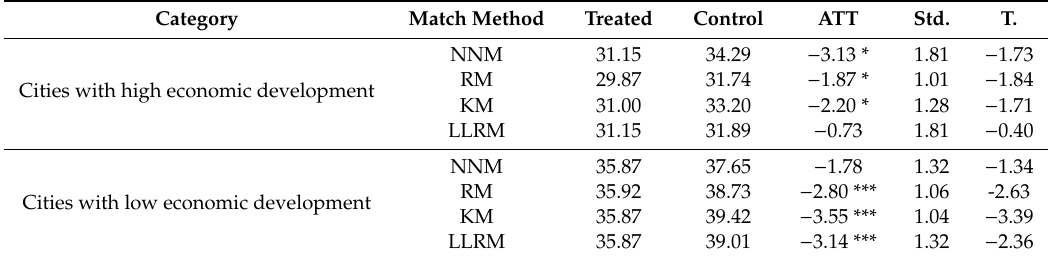
Table 5. ATT estimates in cities with di ff erent economic